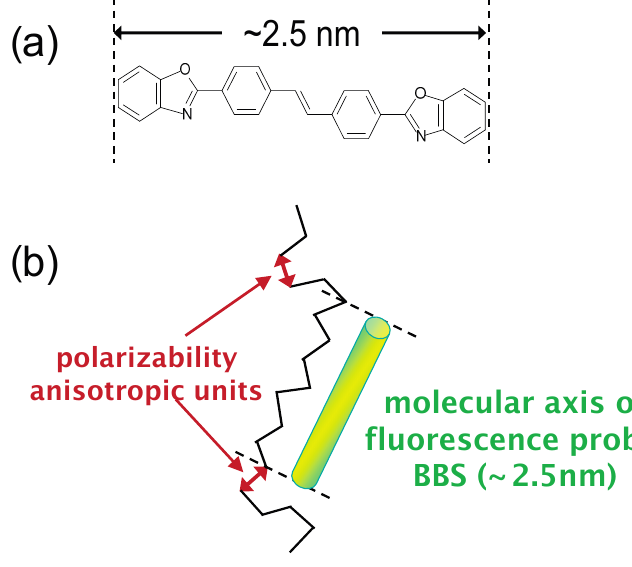
Figure 26. ( a ) Molecular structure of BBS and ( b ) schematic representation of the dimensional and directional differences between the polarizability anisotropic units and BBS.